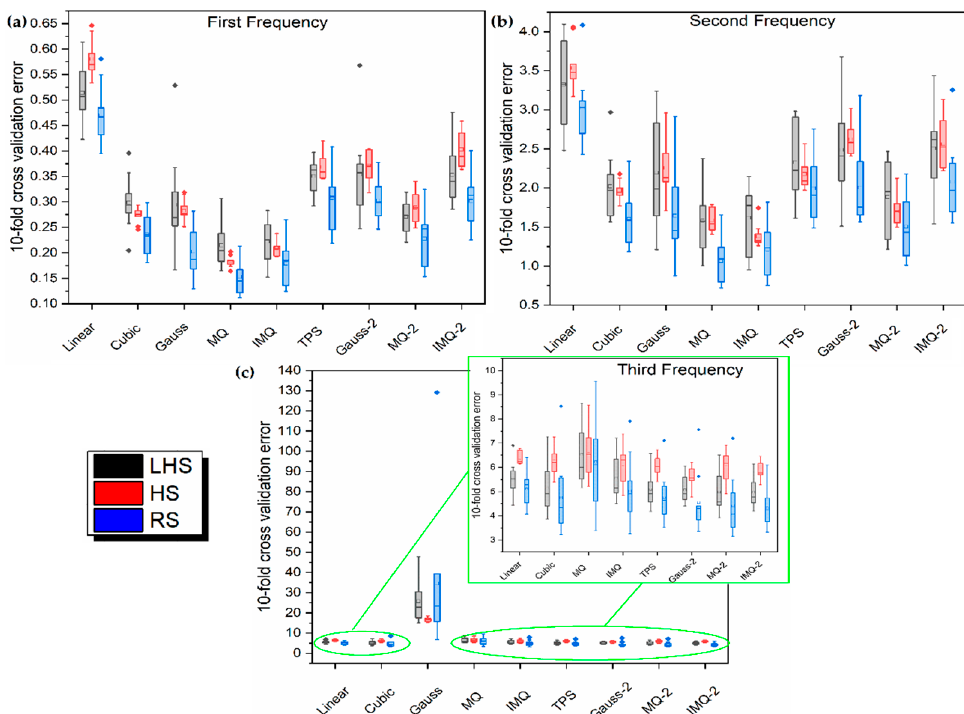
Figure 3. Box plots for 10-fold cross-validation error (30 trials) in LD problem.